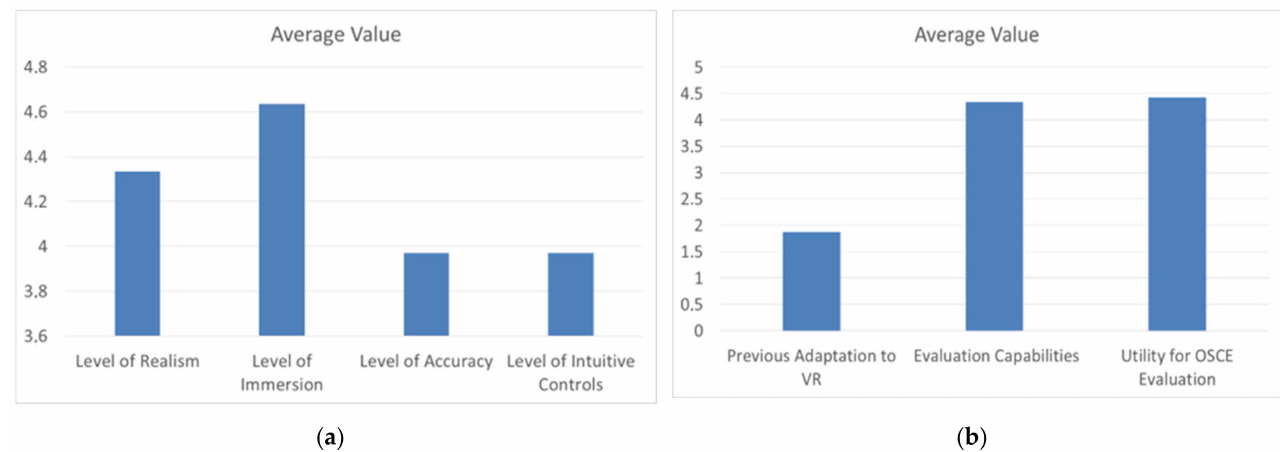
Figure 9. ( a ) Average values of realism, immersion, accuracy and intuition. ( b ) Average of previous adaptation to VR technologies, CPR-OSCE VR evaluation capabilities and utility in OSCE